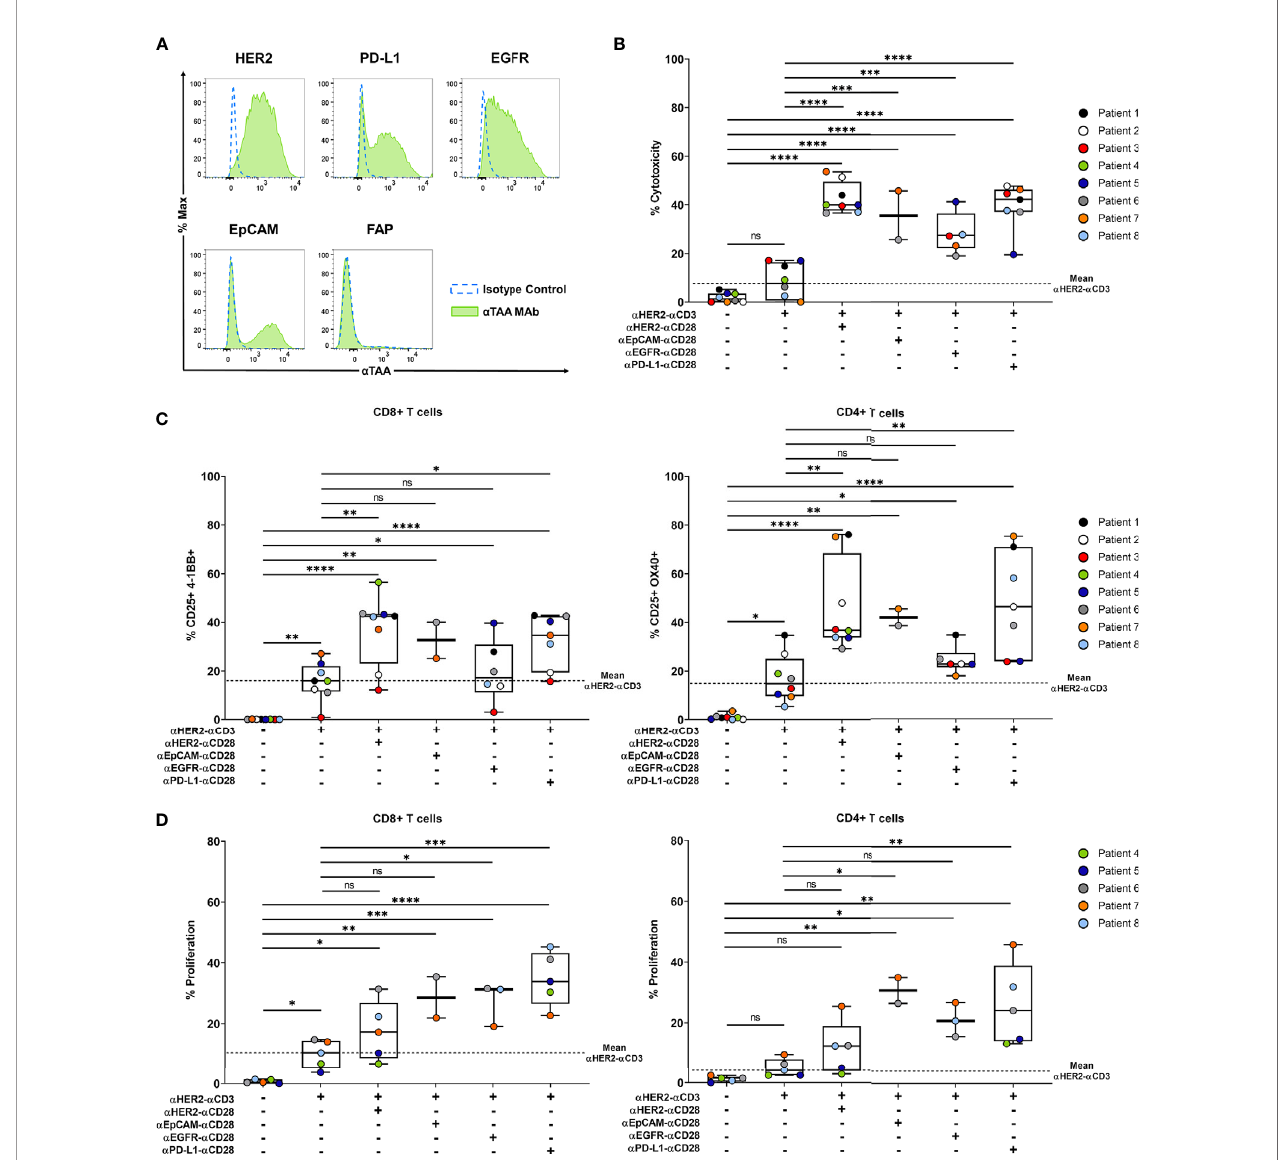
FIGURE 7 | Co-stimulatory BiMAb enhance activation of autologous T cells and induce tumor cell lysis in patient-derived tumor spheroids in vitro. Patient-derived tumor spheroids were generated in vitro with breast cancer cells puri fi ed from pleural effusions and co-cultured with autologous PBMC in the presence or absence of 10 nM a HER2 – a CD3 +/- 10 nM a TAA – a CD28 BiMAb. TAA targeted by co-stimulatory BiMAb were HER2, EGFR, EpCAM and PD-L1. (A) TAA surface expression on puri fi ed tumor cells from a representative patient (#6) was analyzed by fl ow cytometry, staining with isotype control antibodies (dotted blue line) and a TAA mAb (green fi lled line). Examined TAA included HER2, PD-L1, EGFR, EpCAM and FAP. (B) Supernatants were collected after 48 h of co-culture and tumor cell lysis was measured by LDH release assay. (C) Frequencies of CD25 + /4-1BB + CD8 + T cells (left panel) and CD25 + /OX40 + CD4 + T cells (right panel) analyzed via fl ow cytometry after 48 h of incubation. (D) T cell proliferation (CTV dilution) of CD8 + (left panel) and CD4 + (right panel) T cells, analyzed after 5 days of co-culture by fl ow cytometry. Results are shown as box and whisker plots with individual data points of n ≤ 8 patients. Statistical analysis by one-way ANOVA (B – D) with Tukey ’ s multiple comparison test, ns, not signi fi cant; * p < 0.05; ** p < 0.01; *** p < 0.001; **** p <